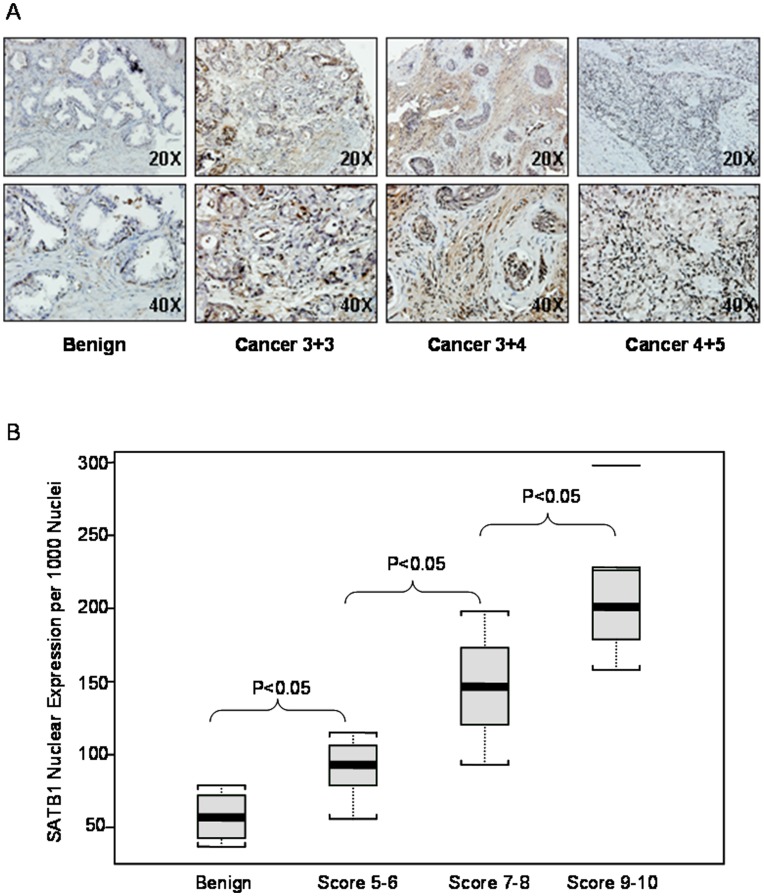
Expression of SATB1 in various representative human prostate specimens.(A) Paraffin-embedded (4.0 µm) sections from benign and prostate cancer of various Gleason scores were used for SATB1 expression by immunohistochemistry. A strong nuclear and cytoplasmic staining was observed in Gleason score 3+3, whereas increased nuclear SATB1 staining was observed in high-grade cancer (Gleason score 3+4 and 4+5, respectively). Magnified at x20 and x40 (B) Statistical analysis of SATB1 nuclear presence was performed by comparing SATB1 positive nuclear stained cells from various locations from benign, score 5–6, score 7–8 and score 9–10 specimens. Data represents the mean±SE. *P<0.05 versus corresponding control. P<0.05, Details are described in ‘materials and methods’ section.